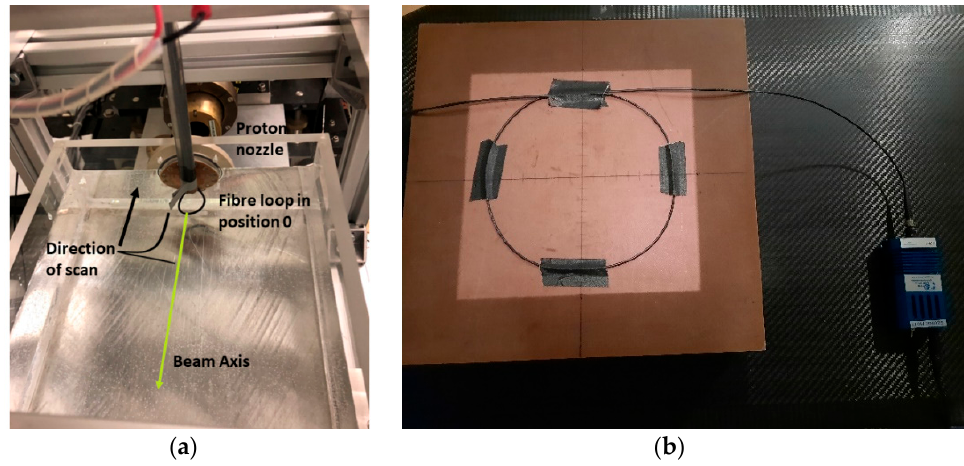
Figure 2. ( a ) setup of the fibre loop in the water box for proton radiation ( b ) setup of the fibre loop on a water equivalent material for X-ray radiation.